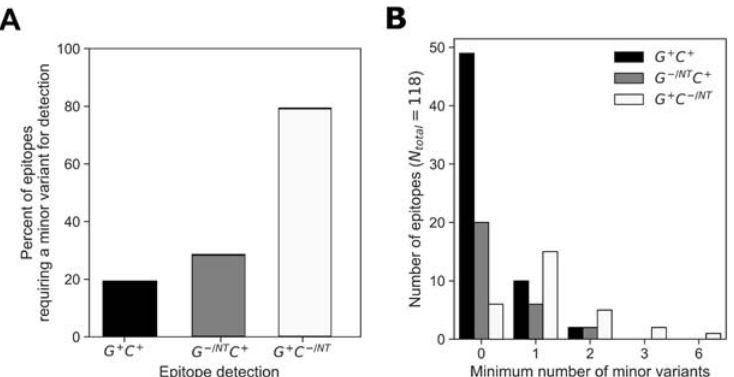
Figure 7. Consensus AA composition in the global and cohort peptides responses. We analyzed for instances when at least one minor variant was required for response detection ( A ) and categorized the determined epitopes in the G + C + , G + C − and G − C + groups to minimum number of minor variants required for detection ( B ).